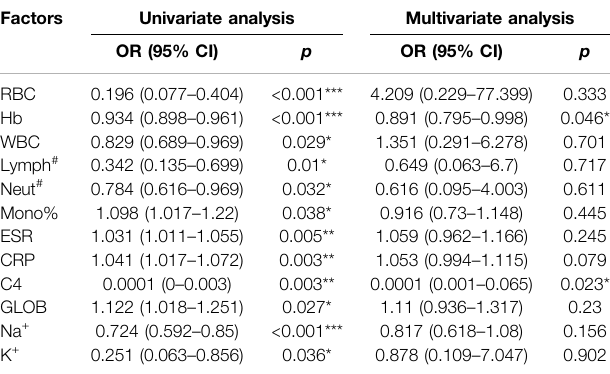
TABLE 2 | Univariate and multivariate logistic regression analyses. Factors Univariate analysis Multivariate